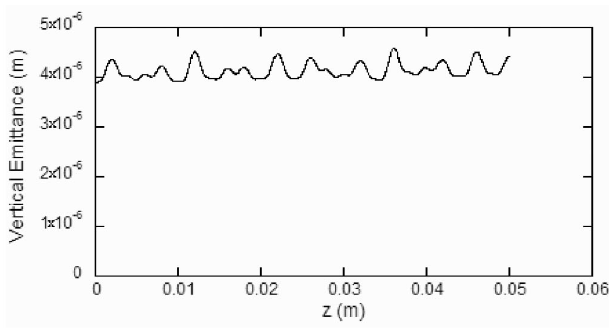
FIG. 16. Vertical emittance, 8-mm